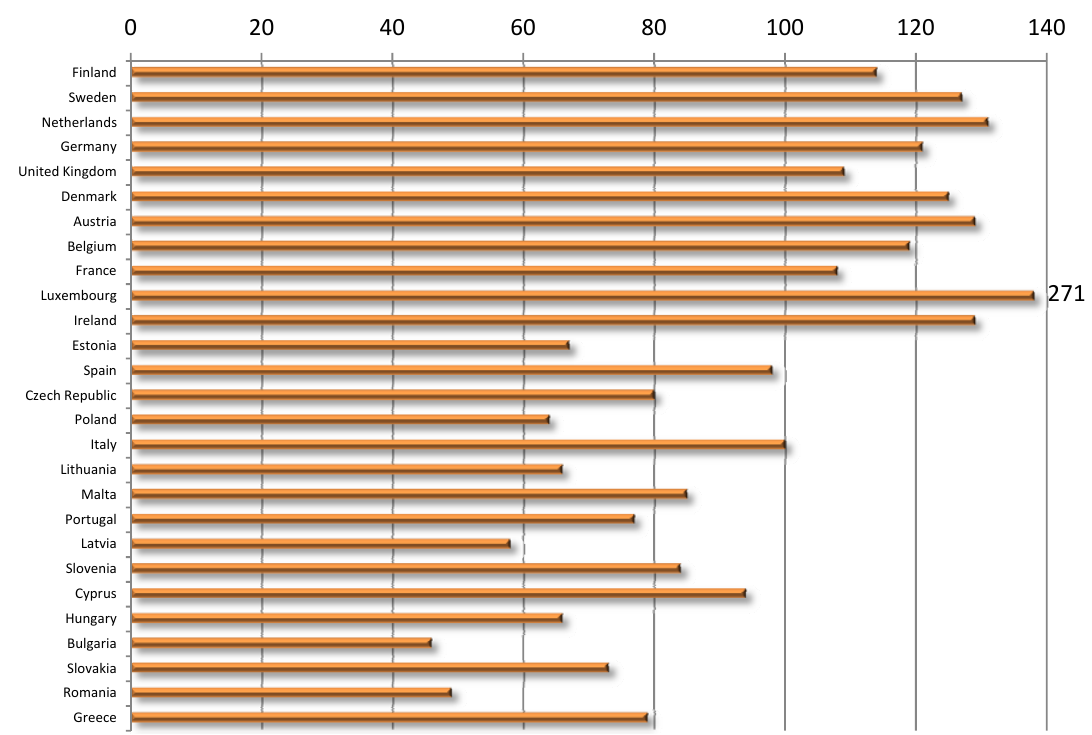
Figure 3. GDP per capita in PPS in EU member states, 2011, EU27 = 100